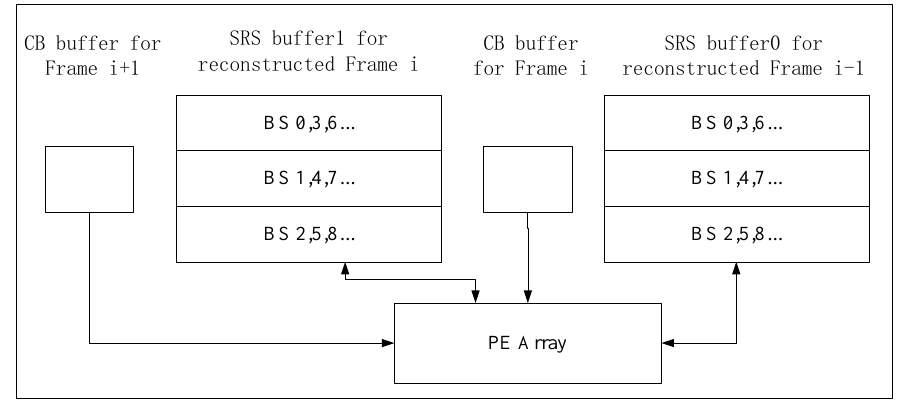
Figure 9. Circular frame buffer design for VC-MRME with Inter-E data reuse. The shaded part is the shared buffer between Frame i and Frame i + 2.